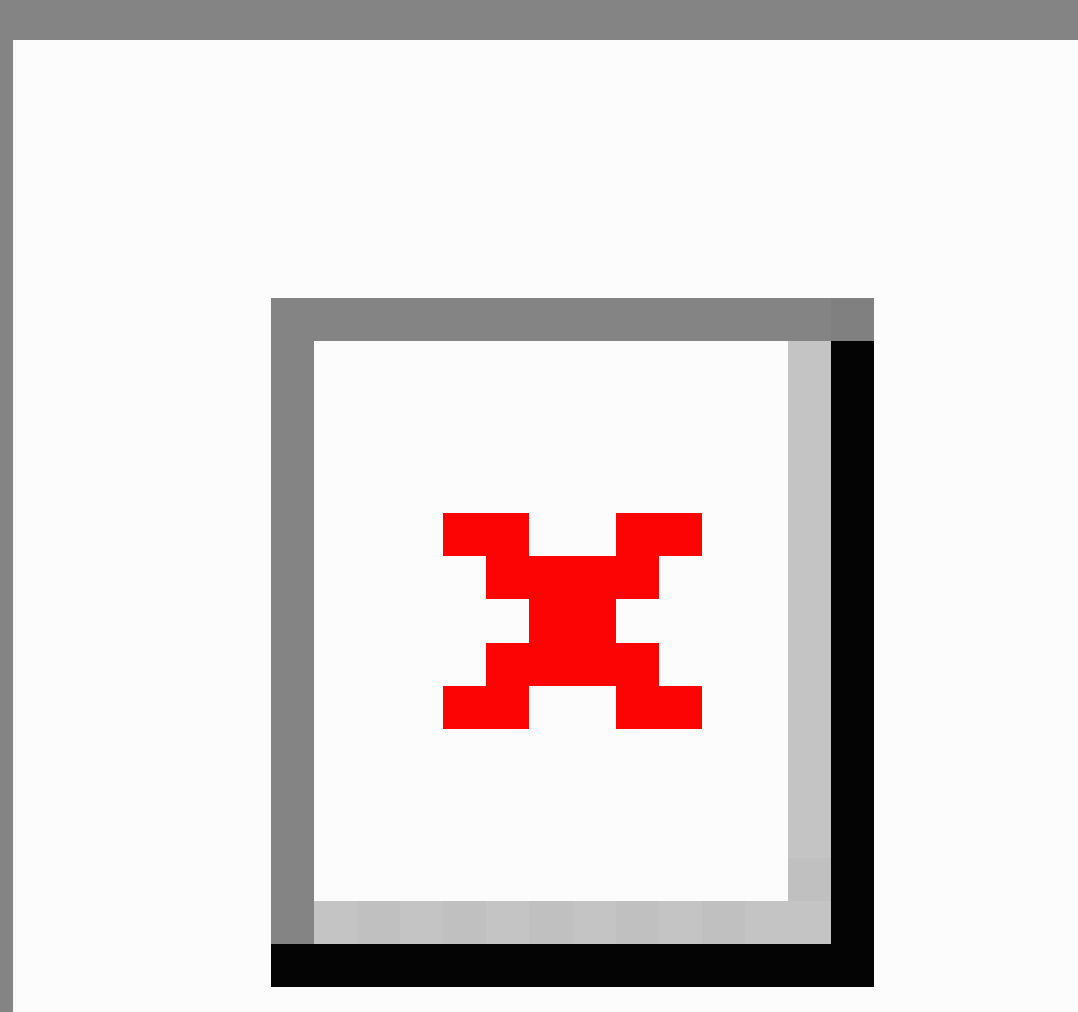
Figure 4. Age/gender distribution of users who searched for mood disorder medications, minus users who only searched for lithium. MSD plot is overlaid on the control plot from Figure 3. When the control value is larger, the control bars (in lighter shades) are visible. When the MSD value is larger, the MSD bars occlude the controls and are marked with lines in the MSD